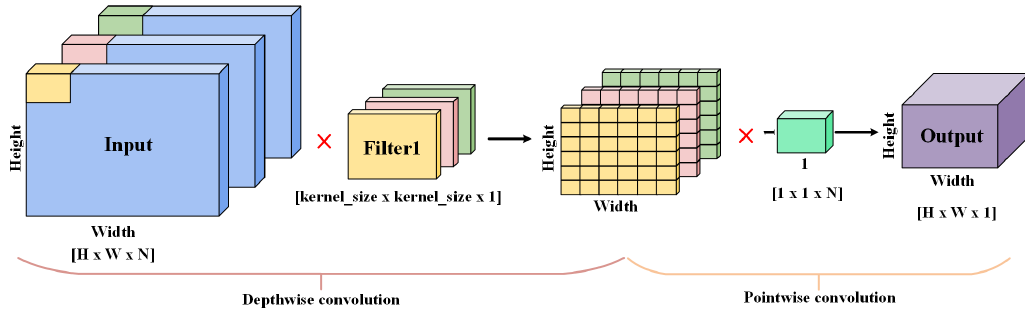
Figure 1. Depthwise separable